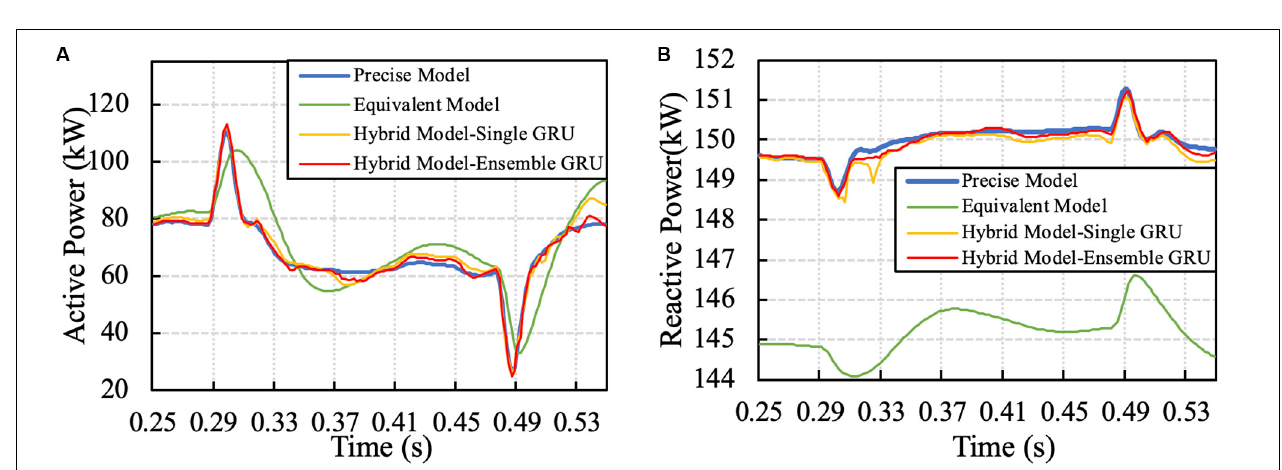
FIGURE 9 | Example of the response of precise, equivalent and hybrid model in Case II: (A) Active power, (B) Reactive power.